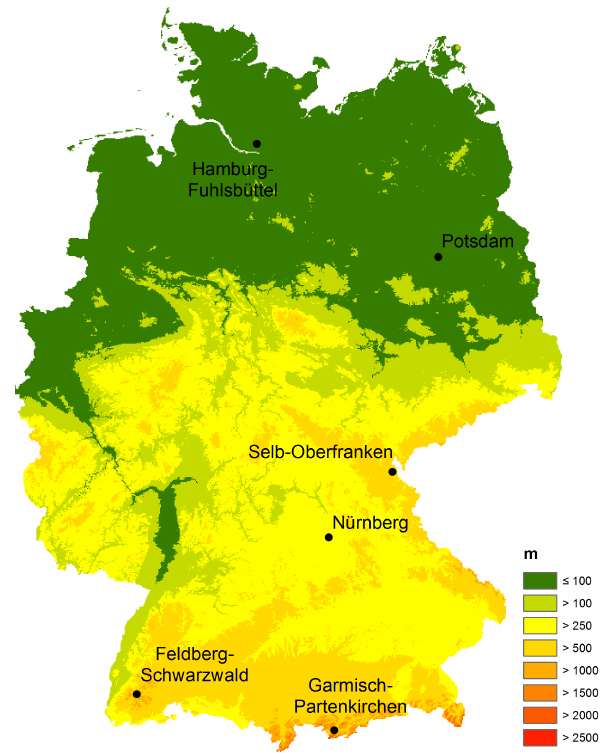
Figure 3. Topography of Germany with colour-coded height above sea level, and location of selected